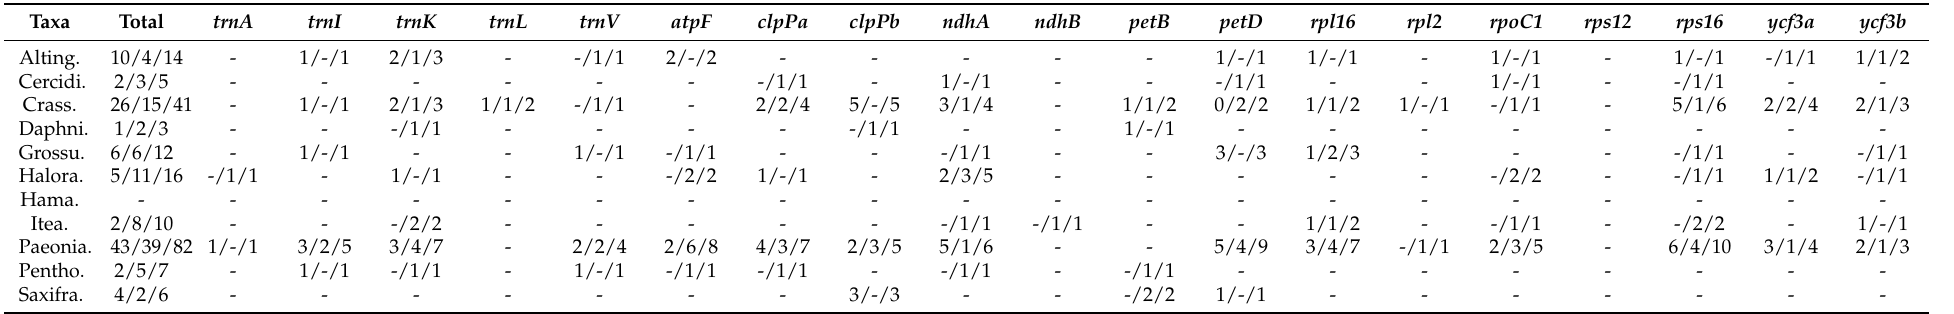
Table 2. Family-specific indels identified from the intron matrix of 17 plastomic genes among